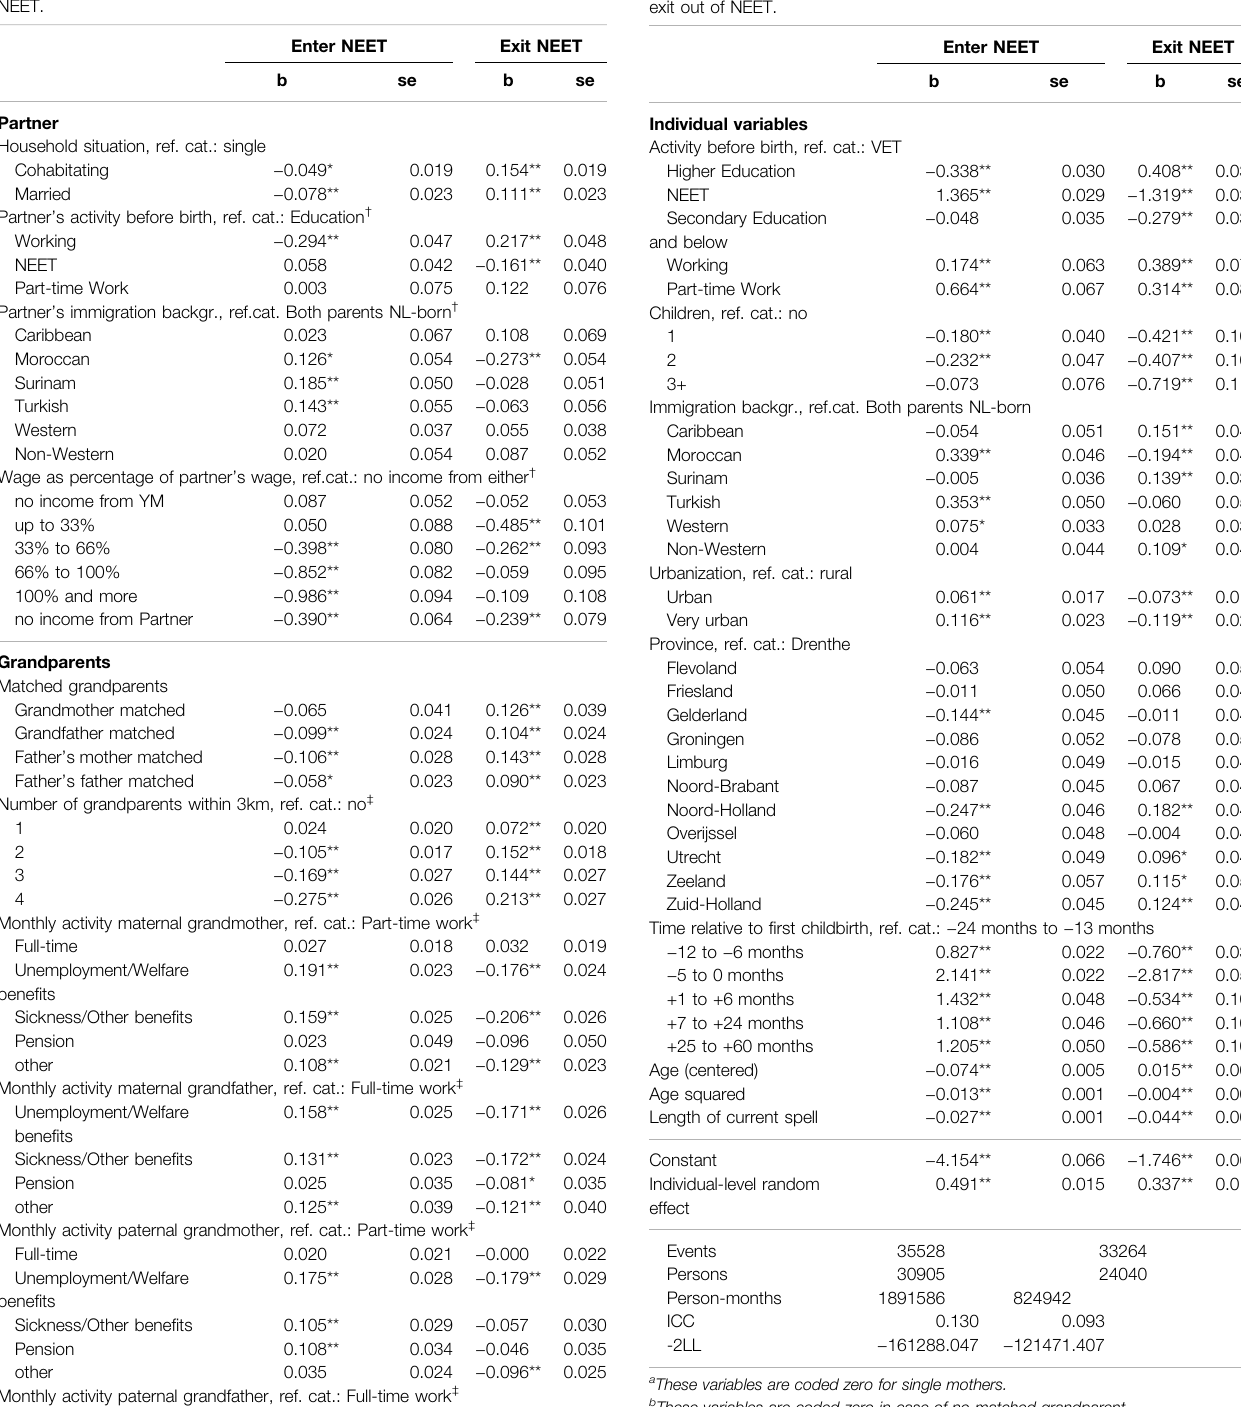
TABLE 5 | Discrete-time event history analysis of available support by grandparents, log odds form logistic regression of entry into and exit out of NEET.